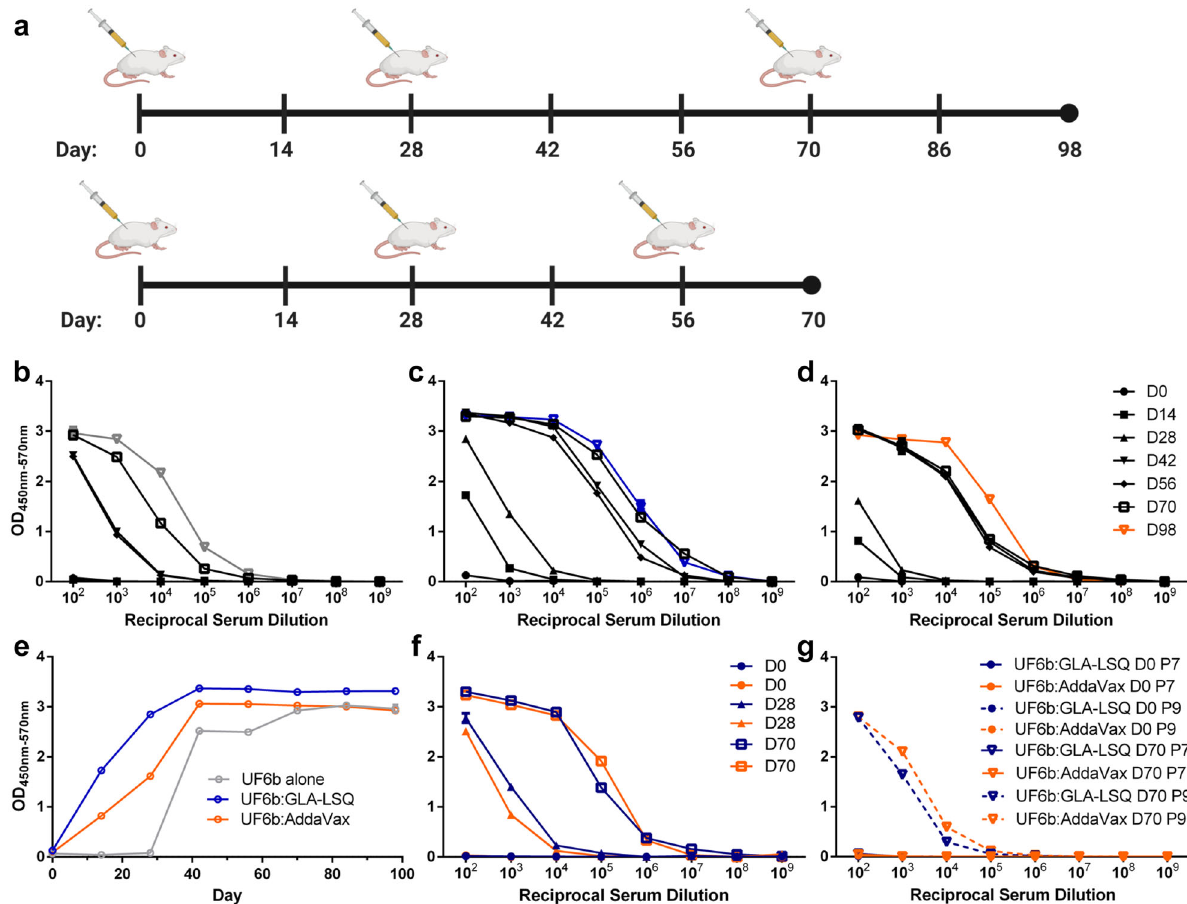
Fig. 3 Immunogenicity of the UF6b construct. a Mice were immunized (i.m.) following a longer D98 prime and two-boost regimen (boosts on Days 28 and 70) or a compressed D70 prime and two-boost regimen (boosts on Days 28 and 56) (20 μ g/dose/mouse). Analyses of the longer regimen sera are shown in ( b – e ). b – d Mice were immunized with UF6b [gray] in the absence of adjuvant ( b ), with UF6b:GLA-LSQ [blue] ( c ), or with UF6b:AddaVax ™ [orange] ( d ). e The kinetics of the antibody (1:100 dilution) response over time. Analyses of the shorter regimen sera are given in ( f - g ): ( f ) UF6b-speci fi c ELISA with sera from mice immunized with UF6b with either GLA-LSQ [blue] or AddaVax ™ [orange] in the 70-Day study. g Peptide 7 [P7] and peptide 9 [P9] speci fi c ELISA of the same 70-Day study. ELISA analyses used pooled sera collected at the designated timepoints. Absorbances taken at 570 nm were deducted from absorbances at 450 nm to account for background. Error bars indicate SEM of triplicates; however, error was tightly controlled between replicates resulting in compact bars obscured by the data points. D,